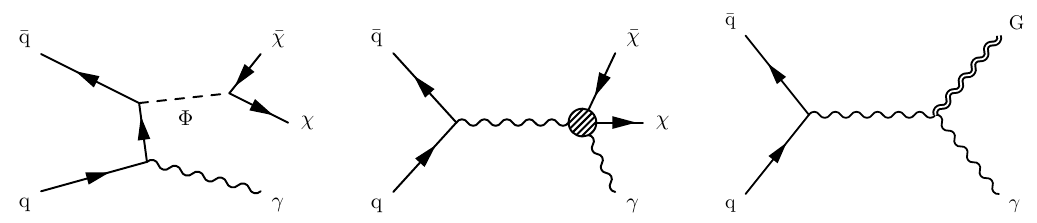
Figure 1 . Leading order diagrams of the simpli(cid:12)ed DM model (left), EWK-DM e(cid:11)ective interaction (center), and graviton (G) production in the ADD model (right), with a (cid:12)nal state of a photon and large p miss . Particles (cid:31) and (cid:31) are the dark matter and its antiparticle, and (cid:8) in the simpli(cid:12)ed DM T model represents a vector or axial-vector